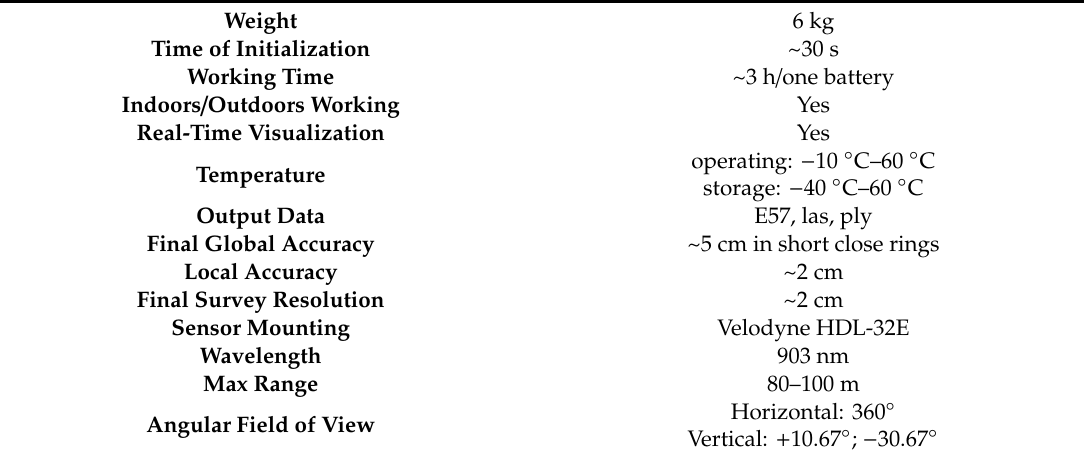
Table 2. Technical specifications of the Heron AC-1 Color wearable mapping